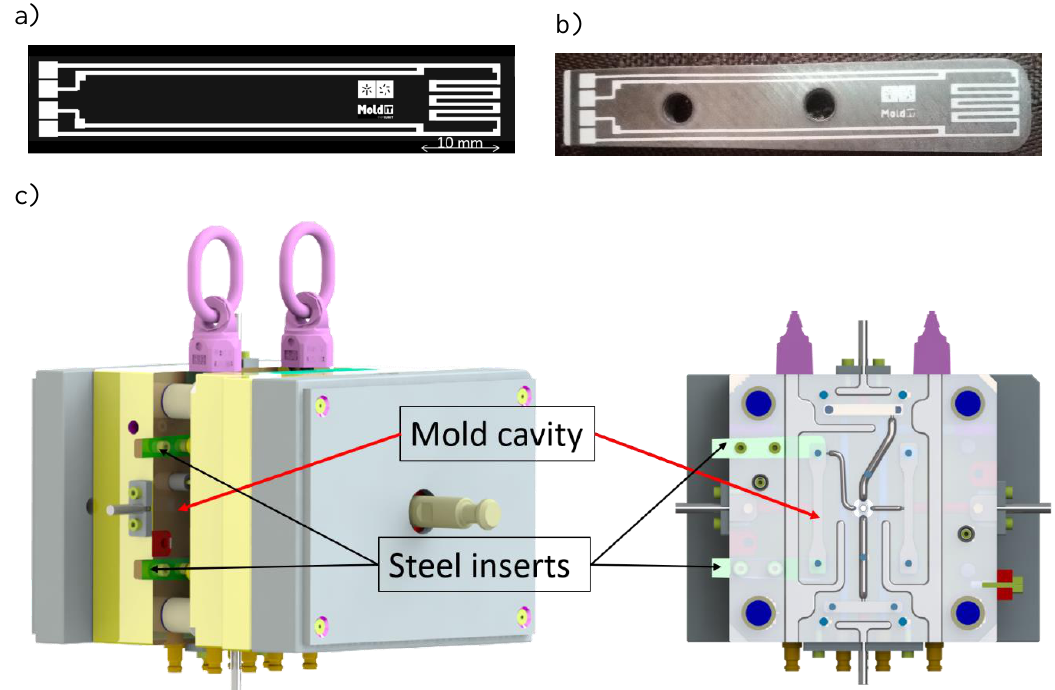
Figure 3. ( a ) Draw of the designed sensor; ( b ) draw transferred to the steel inserts by lift-off; and ( c ) schematic representation of the mold cavity and the place where the steel inserts are placed.